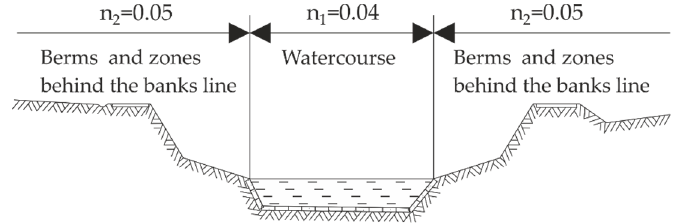
Figure 8. Cross-section and estimation of Manning’s roughness value. Figure 8. Cross ‐ section and estimation of Manning’s roughness value.